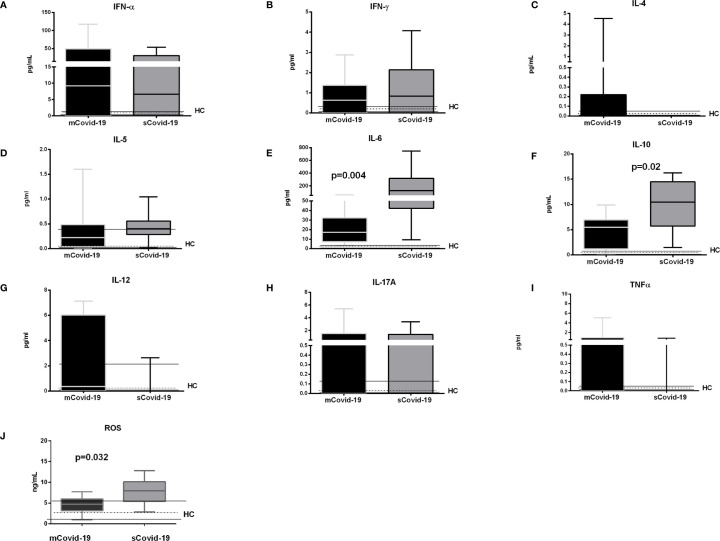
Levels of plasma cytokines and oxidative stress according to the degree of Covid-19 diseases. Plasma samples were collected and analyzed from blood samples of 20 COVID-19 patients [severe Covid-19 (sCovid-19) n = 10 and mild Covid-19 (mCovid-19) n = 10]. (A–D) No major differences in Interferon (IFN)-α, IFN-γ, Interleukin (IL)-4 and IL-5 were observed between (mCovid-19) and (sCovid-19). (E, F) We observed increased levels of IL-6 and IL-10 in sCovid-19 compared to m-Covid-19 (p = 0.004 and p = 0.02). (G–I). The levels of IL-12, IL-17A and tumor necrosis factor (TNF)-α were comparable between mCovid-19 and sCovid-19. (J) sCOVID-19 patients showed significantly higher circulating levels of reactive oxygen species (ROS) in comparison to mCOVID-19 patients (p  =  0.032). Graph box and whiskers represent medians and 10th–90th percentile range. Dotted lines indicate the median levels, and solid lines indicate 10th–90th range of healthy controls (HCs) from archived material. Comparison between groups (sCovid-19 vs mCovid-19) Mann–Whitney test.